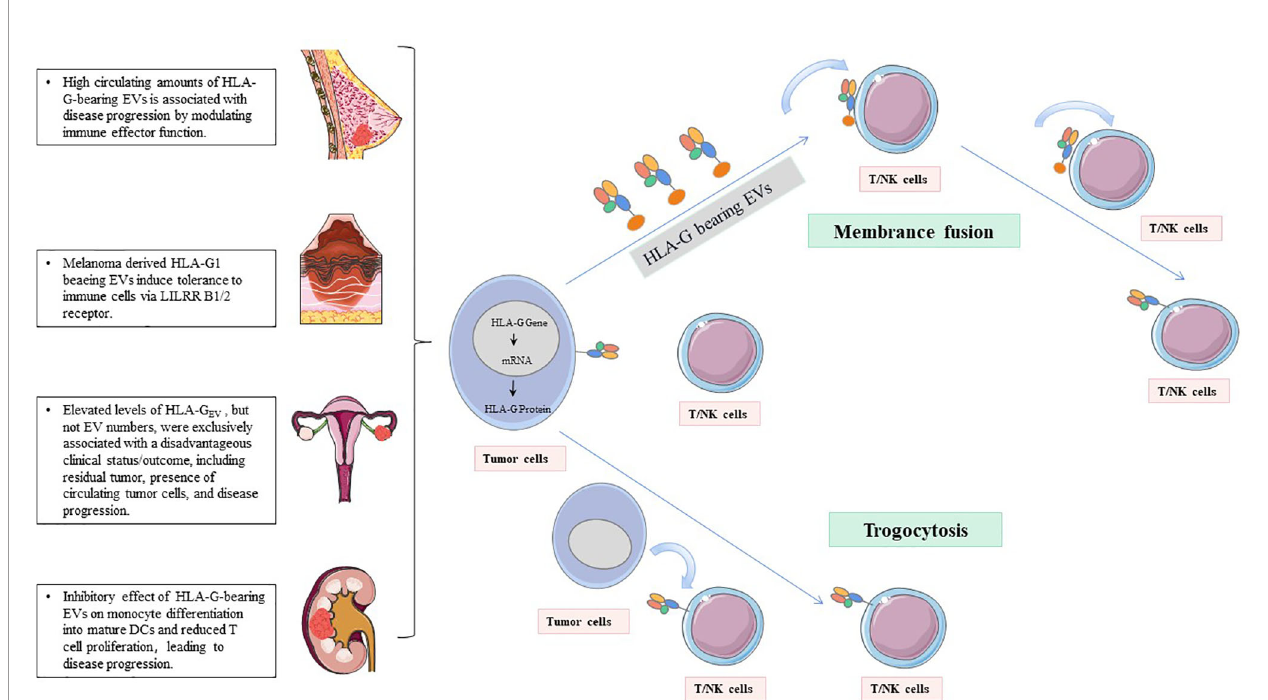
FIGURE 2 | HLA-G-bearing EVs with potential immunological and clinical relevance. NK cells and T cells acquire HLA-G from HLA-G+tumor cells or HLA-G+immune cells via the process of trogocytosis and/or